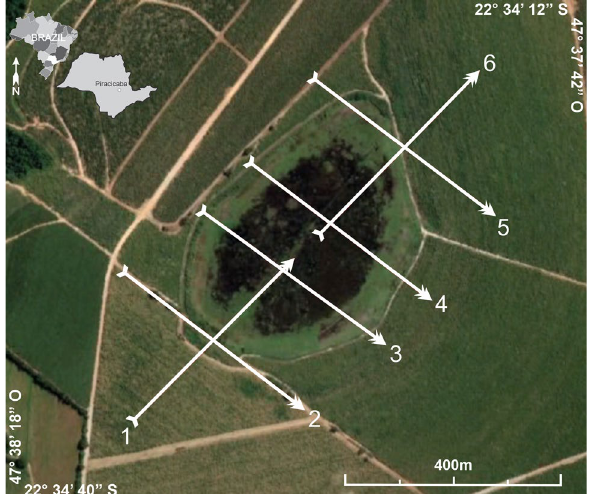
Fig. 5 Arrangement of electri- cal resistivity tomography